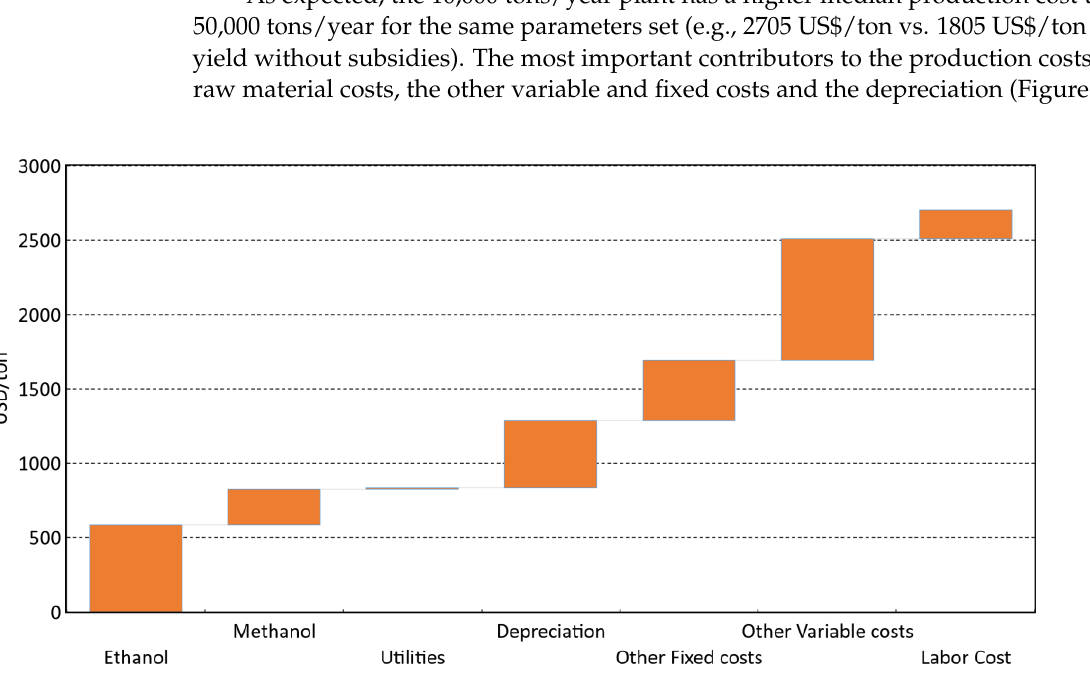
Figure 22. Production cost cascade for small plant (10,000 tons/year), 70% yield, without subsidies. Utilities (electricity and water) are calculated as 2% of raw materials cost. Depreciation is done over 10 years. Other fixed costs represent 9% of the capital cost. Other variable costs represent 18% of the sales. Labor cost represents 1.9 M US$/year.